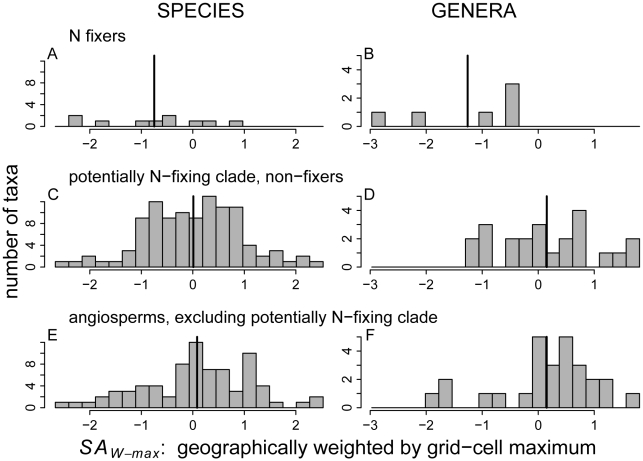
Histograms of the geographically weighted stand age index, SAW-max.Panels are defined as in Fig. 4. SAW-max accounts for geographical variation in maximum stand age (Fig. S3), and is expressed as the number of standard deviations from the overall angiosperm mean (see Methods for details).